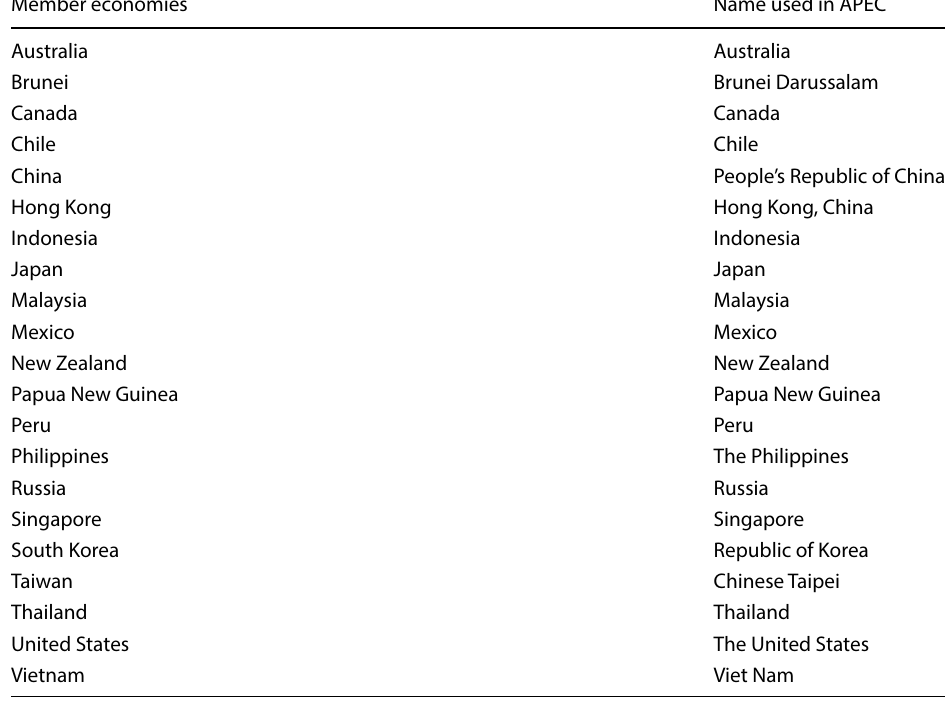
Table 1 APEC Member